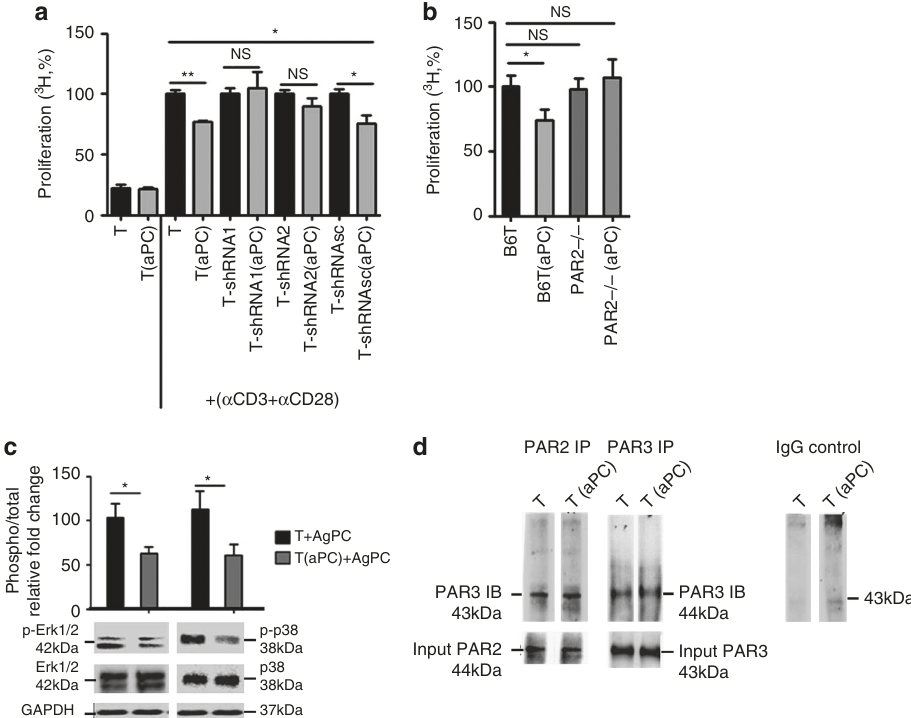
Fig. 7 aPC signaling requires PAR2 in addition to PAR3 on T-cells. a Following knockdown of PAR2 in human primary pan T-cells (T) using two different shRNAs (shRNA1 and shRNA2) the inhibitory effect of aPC on T-cells after stimulation with α CD3 and α CD28 antibodies is lost. Scrambled shRNA ( shRNAsc ) had no effect. Bar graph summarizing results from fi ve repeat experiments using fi ve biological disjunct donors, each in triplicates. b Preincubation of T-cells from C57BL/6 wild type (B6T(aPC)) mice, but not of C57BL/6 PAR2-de fi cient (PAR2 − / − (aPC)) mice, with aPC and subsequent stimulation with plate-bound α CD3 and α CD28 antibodies, abrogates aPC ’ s inhibitory effect on T-cell reactivity. c Preincubation of human pan T-cells with aPC reduces ERK1/2 and p38 activity after 96 h MLR as re fl ected by reduced phosphorylation of these proteins (normalized to the corresponding total protein levels) as determined by immunoblot; bar graph re fl ecting mean results ± SEM ( top ) and representative immunoblots ( bottom ) are shown. d Exemplary immunoblot showing interaction of PAR2 and PAR3 in human T regs analysed using immunoprecipitation for PAR2 followed by immunoblotting of PAR3 and vice versa. Immunoprecipitation using IgG was used as negative control. Immunoblot of PAR2 and PAR3 was done as a input control. Mean value ± SEM ( a , b ), results of at least three repeat experiments each with three biological disjunct donors ( a , c ) or from fi ve different mice ( b ). *P < 0.05, ** P < 0.01, NS non signi fi cant ( a , b ANOVA; c t